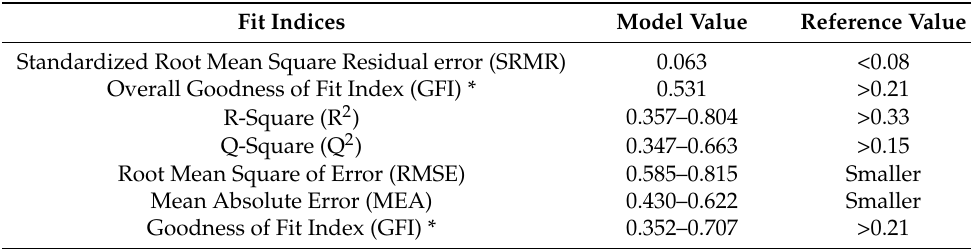
Table 7. Fit indices of PLS-SEM on the research model.